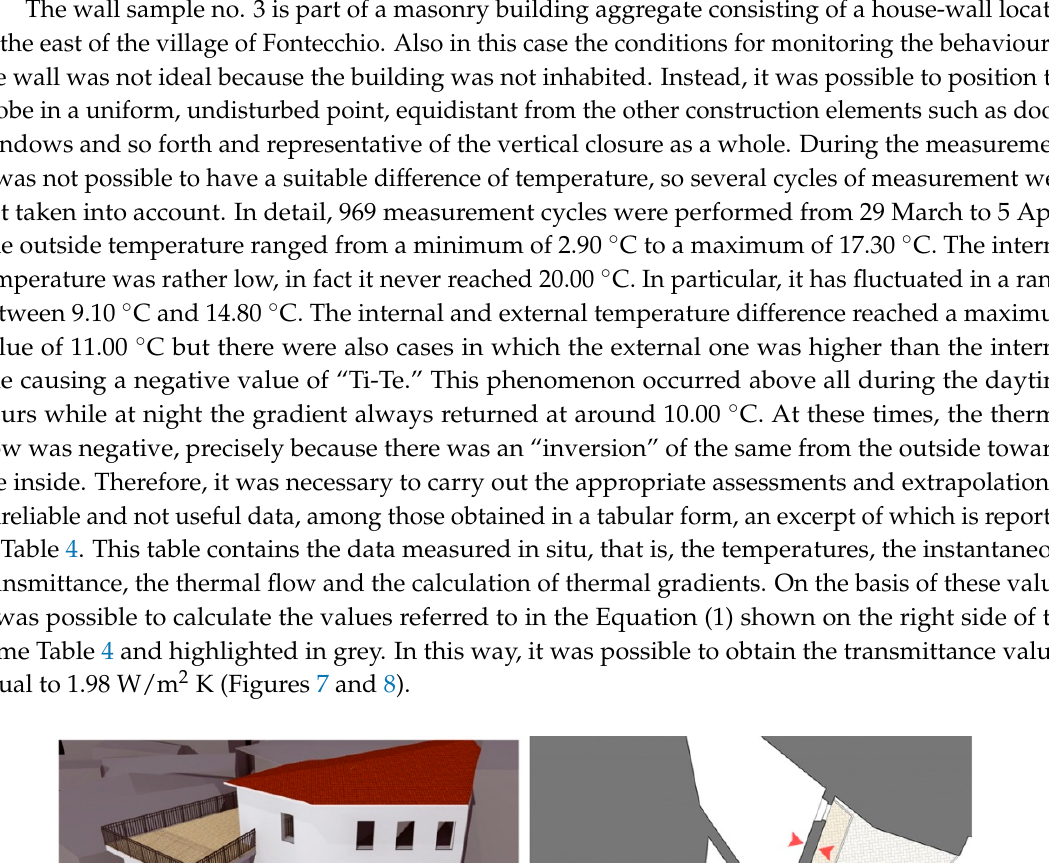
Figure 8. Part of the data detected by the thermal flux meter. Graphical output.